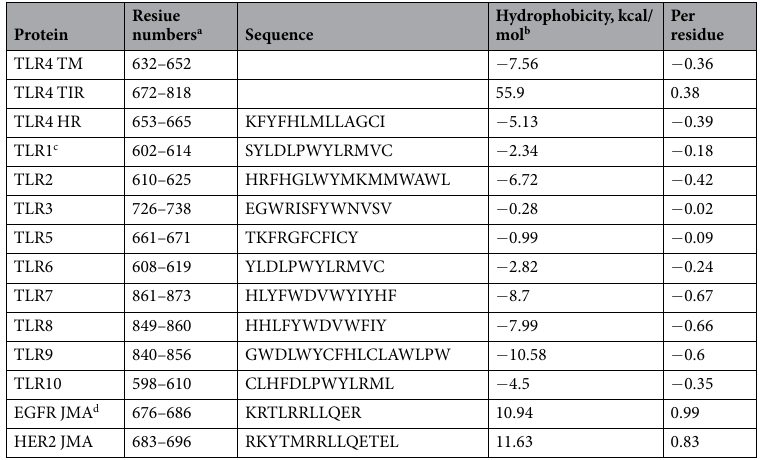
Table 1. Hydrophobic properties of TLR juxtamembrane regions. a Residue numbering is given according to Uniprot. b Hydrophobicity is a sum of contributions of distinct residues, according to ref. 34. c Here and below shown are the first 11–16 residues immediately after the TM domain of corresponding TLR, until the encounter of first polar aminoacid. d Cytoplasmic juxtamembrane helix of the EGFR and HER2